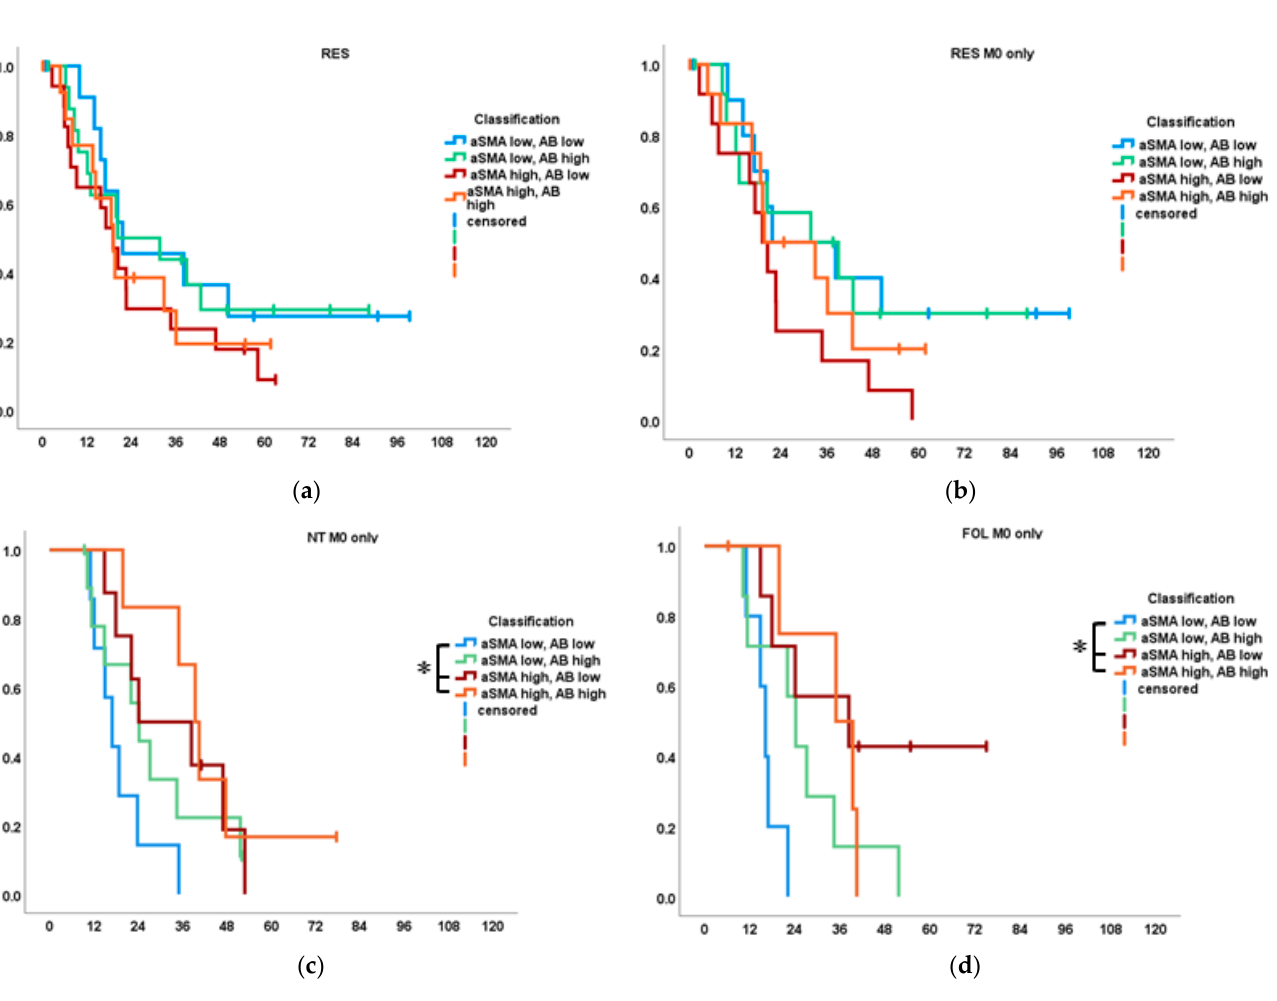
( f ) Figure 3 . Overall survival (OS; months) of subgroups by tissue parameter quartiles (Q). ( a ) OS of RES M0 according to ASI; each Q n = 13 ( ✻ Q1 vs. Q4: p = 0.047); ( b ) OS of NT M0 according to ASI; each Q n = 8; ( c ) OS of FOL according to ASI; each Q n = 7 ( ✻ Q4 vs. Q1–3: p = 0.045); ( d ) OS of GEM according to ASI; high vs low, each n = 3 ( p = 0.025) ( e ) OS of RES M0 according to α -SMA each Q n = 13; ( f ) OS of NT M0 according to α -SMA; each Q n = 8 ( ✻ Q1 + 2 vs. Q3 + 4: p = 0.010). 3.3.3. Fibrogenic, Inert, Dormant and Fibrolytic Stroma As an alternative to the arithmetic ASI, we analyzed survival classified by combinations of high and low α -SMA and AB according to median expression, as described before [28], and again found differing associations with OS between RES and NT groups: while median OS was comparable between the classes in RES at a range of 19.1–21.6 months (Figure 4a; RES M0: 19.1–31.7, Figure 4b) and low α -SMA classes represented a trend for best outcomes in RES (Figure 4a), in NT, high α -SMA was associated with a distinct survival advantage. The “inert” = low α -SMA/low AB class universally had the worst outcome in NT, NT M0 (Figure 4c), FOL and FOL M0 (Figure 4d). This was significant in NT for the low α -SMA/low AB class ( n = 9) at 18.8 months (14.3–23.3) vs. both “fibrolytic” stroma = high/low at 24.1 ( n = 12; 2.2–46.0; p = 0.032) and